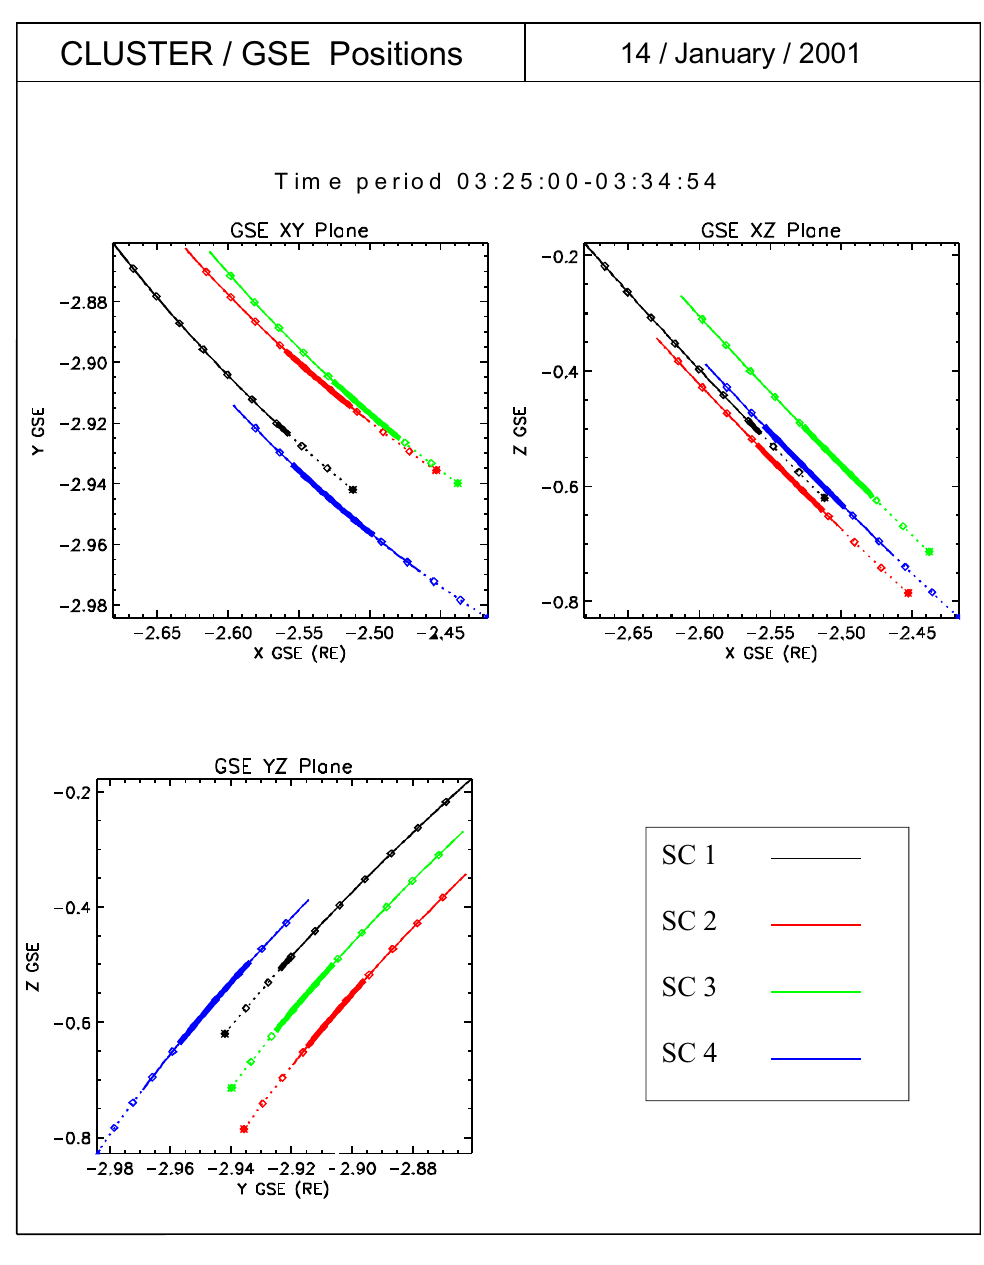
Fig. 8. Projection of the four Cluster trajectories in the 3 GSE planes. Dotted lines correspond to periods for which there was no wave data acquisition. Thick lines correspond to the periods where the amplitude of the waves is higher than half of the maximum amplitude. This shows that the waves are confined to regions between − 0.5 and − 0.65 R E in the Z -direction, at about 3 ◦ of geomagnetic